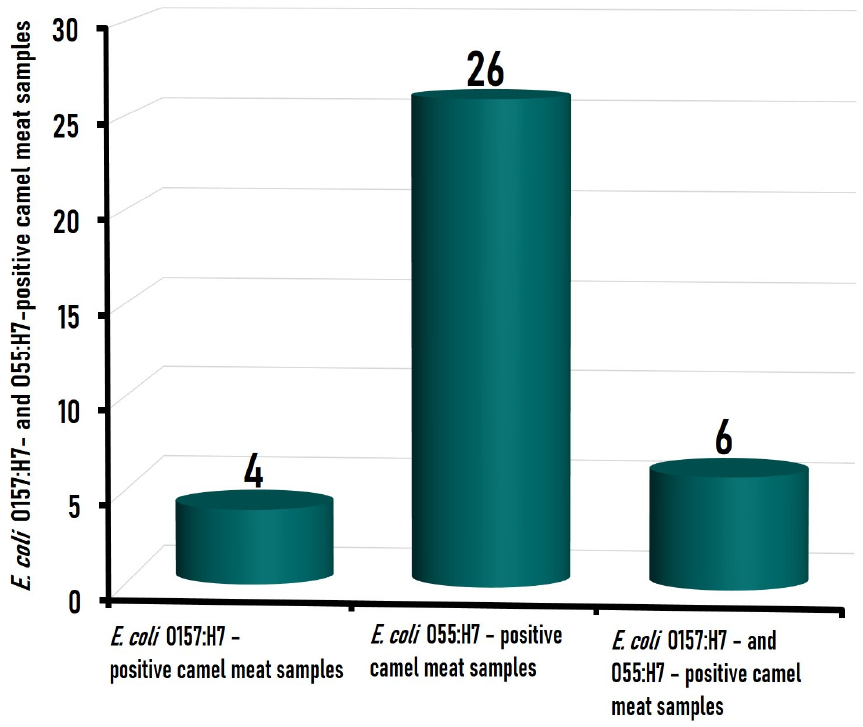
Figure 1. Number of camel meat samples contaminated with Escherichia coli O157:H7 and Escherichia coli O55:H7, from the total of 110 investigated.